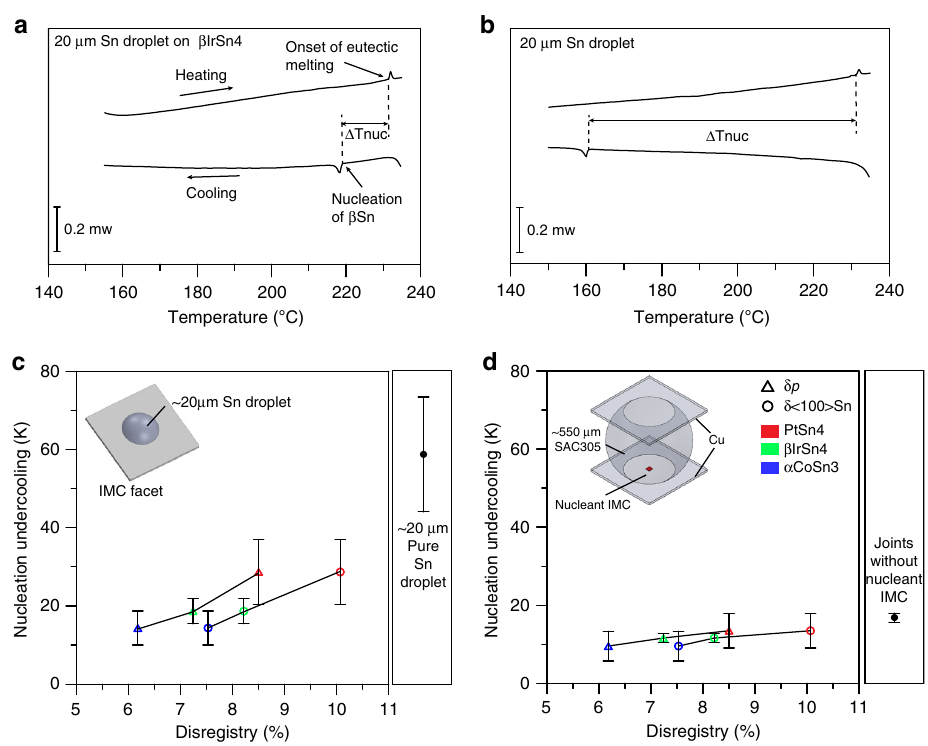
Fig. 4 Nucleation undercooling vs. lattice mismatch. Typical DSC curves and de fi nition of nucleation undercooling in a a single ~20 µ m Sn droplet on the (001) facet of a β IrSn 4 single crystal and b a freestanding single ~20 µ m Sn droplet. c The nucleation undercooling for β Sn in ~20 µ m Sn droplets on the IMC facets vs. planar disregistry and linear disregistry along < 100 > Sn. d The nucleation undercooling of 550 µ m Cu/SAC305 + IMC/Cu solder joints vs. planar disregistry and linear disregistry along < 100 > Sn. Each datapoint and error bar represent the mean nucleation undercooling and standard deviation from at least 25 measurements. All samples were measured on inert oxidized Al suppressed compared with the solidi fi cation of ~20 µ m droplets on inert oxidized Al substrates (58 ± 15 K). It can also be seen in Fig. 4c that the lower the disregisty, the smaller the nucleation undercooling for both methods of quantifying lattice mismatch, – 41 . At the same time, consistent with nucleant potency theories 39 in Fig. 4c, note that the nucleation undercoolings of ~20 µ m droplets on the IMC facets are not very small compared with potent nucleants in other systems (e.g., Al on Al 3 Ti 44 ). However, importantly, the ORs in Table 2 formed in 182 out of 182 droplets and, irrespective of which OR formed, the [001] of tetragonal β Sn was always in the plane of the largest facet of the IMC. Thus, these ORs are not only reproducible but also useful since, by controlling the orientation of the largest facet in a joint, these IMCs have the potential to be used as seed crystals to control the orientation of the [001] of β Sn in solder joints.